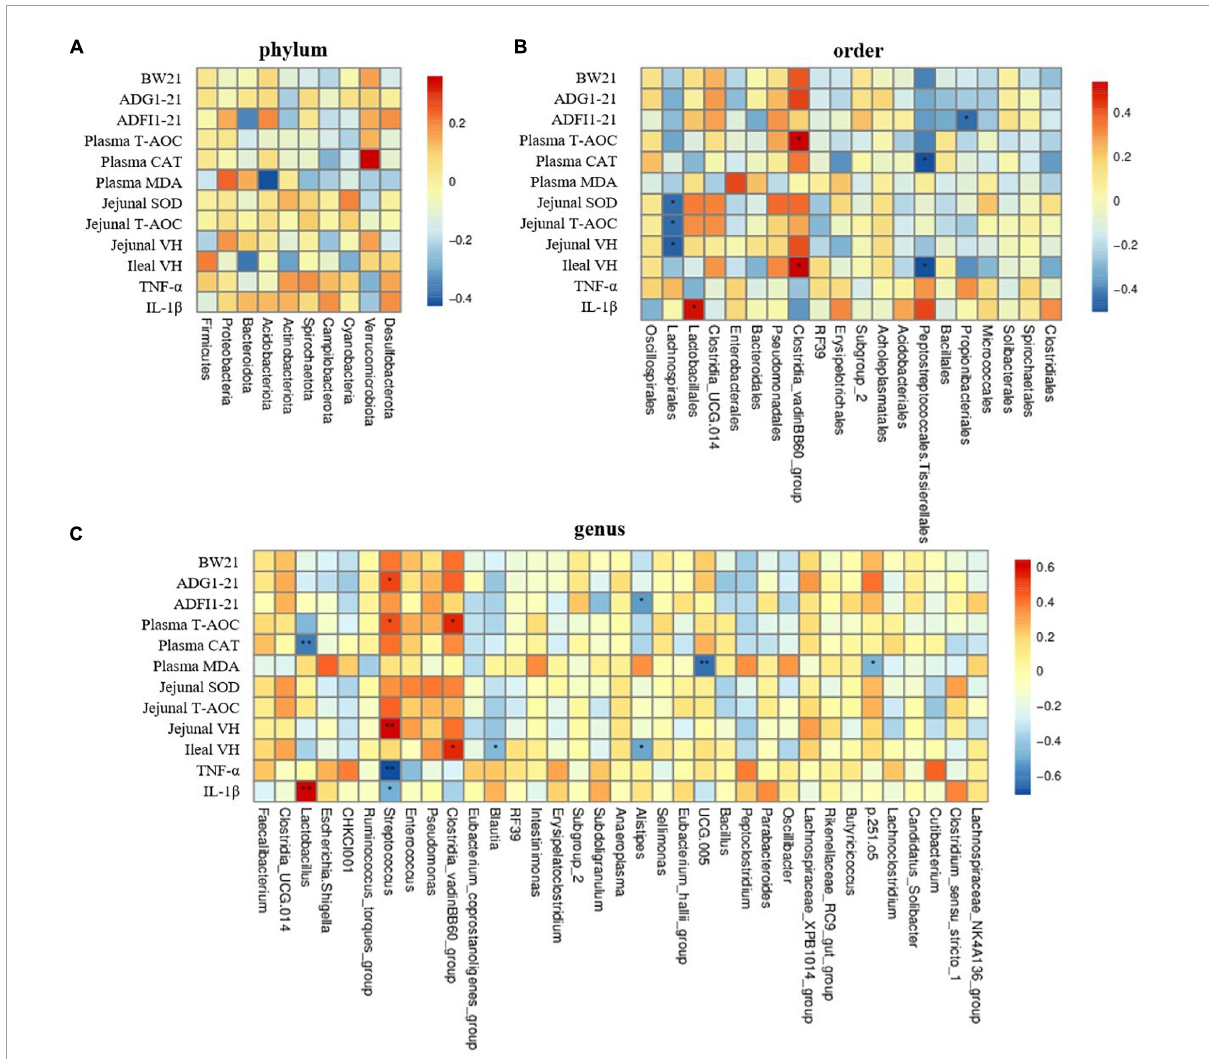
FIGURE7 The Spearman correlation analysis of gut microbial composition at phylum, order, and genus levels with growth performance, antioxidant capacity, and intestinal health in yellow-feathered broilers. Spearman correlation coefficients of BW at 21 days, ADG and ADFI during 1–21 days, plasma and jenual antioxidant capacity, villus height at jejunum and ileum, and cytokine concentrations with representative cecal microbiota at phylum (A) , order (B) , and genus (C) level, are represented by color ranging from red (positive correlation) to blue (negative correlation), respectively. ∗ and ∗∗ indicates statistically significant difference ( P < 0.05) and ( P < 0.01), respectively. BW, body weight; ADG, average daily gain; ADFI, average daily feed intake; T-AOC, total antioxidant capacity; CAT, catalase; SOD, superoxide dismutase; MDA, malondialdehyde; VH, villus height; TNF- α , tumor necrosis factor- α ; IL-1 β , interleukin-1 β